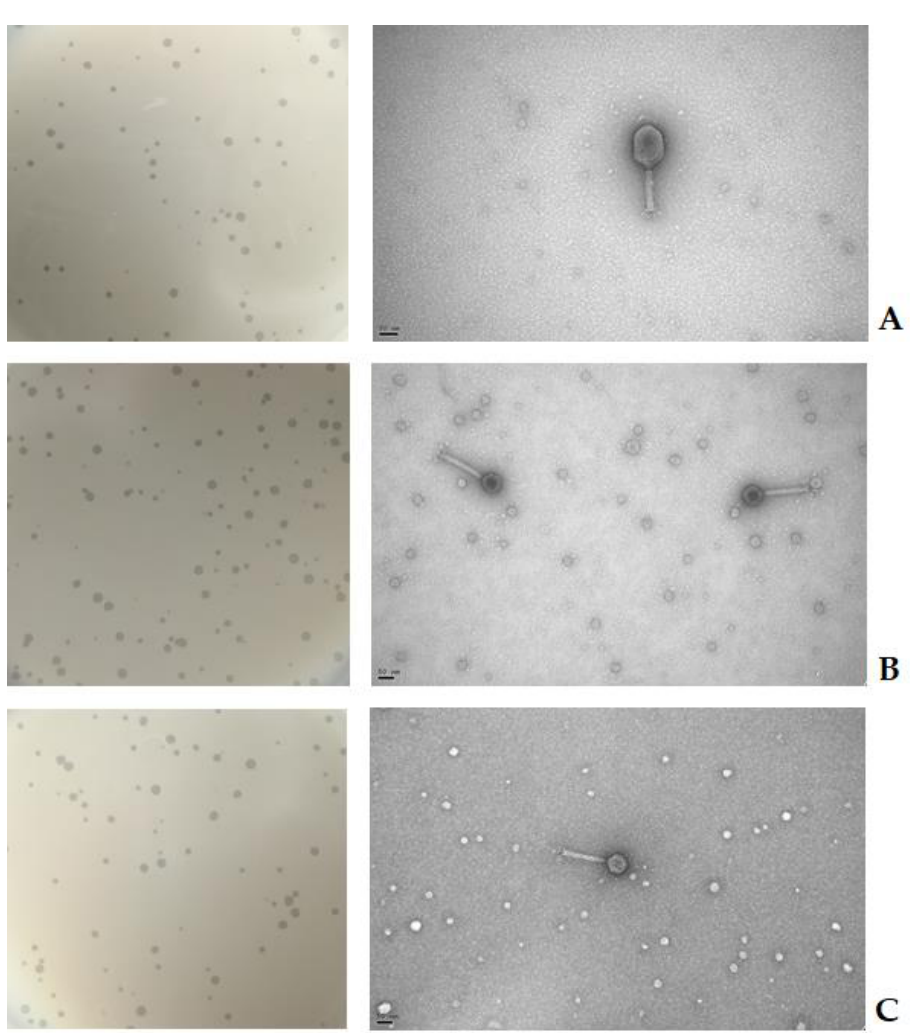
Figure 1. Phage plaque morphologies and electron micrographs of A. hydrophila phages: ( A ) Phage AH-1; ( B ) Phage AH-4; and ( C ) Phage AH-5. The bars represent 50 nm.